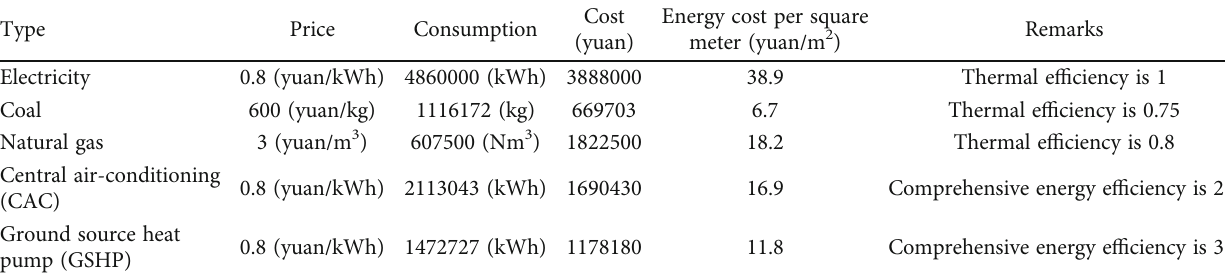
Table 6: Energy cost of di ff erent heating modes.